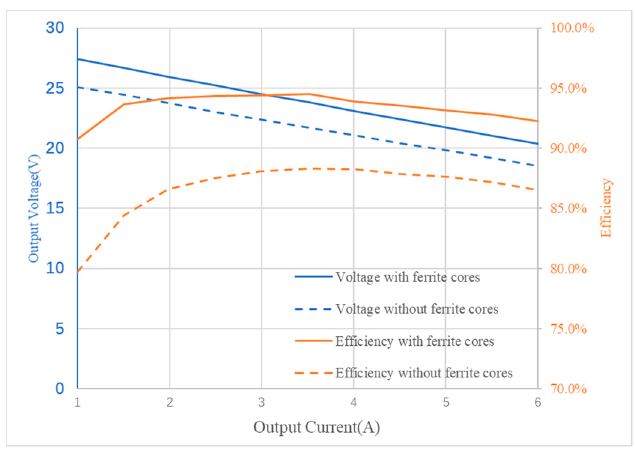
Figure 20. Relationships among the efficiencies, load currents, and voltages.